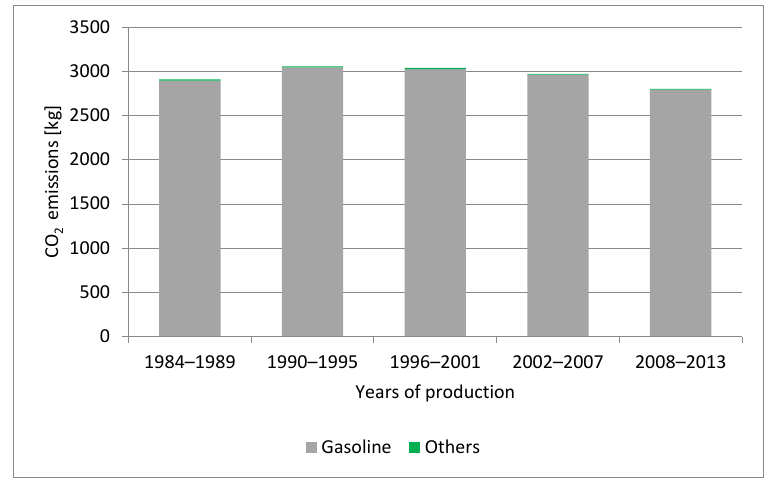
Figure 5. CO 2 emissions for the entire passenger car.